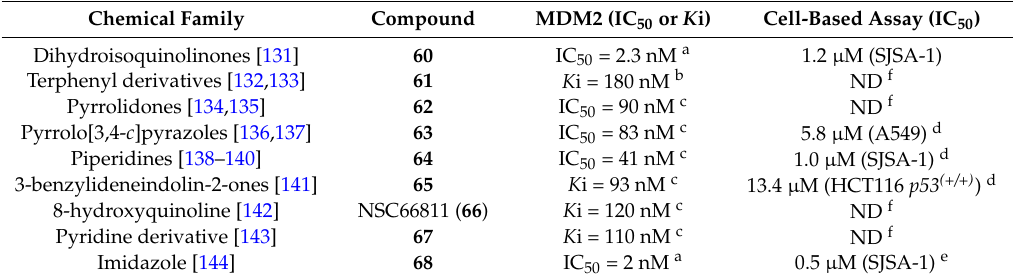
Table 2. Other chemical families described for p53-MDM2 interaction inhibitors.